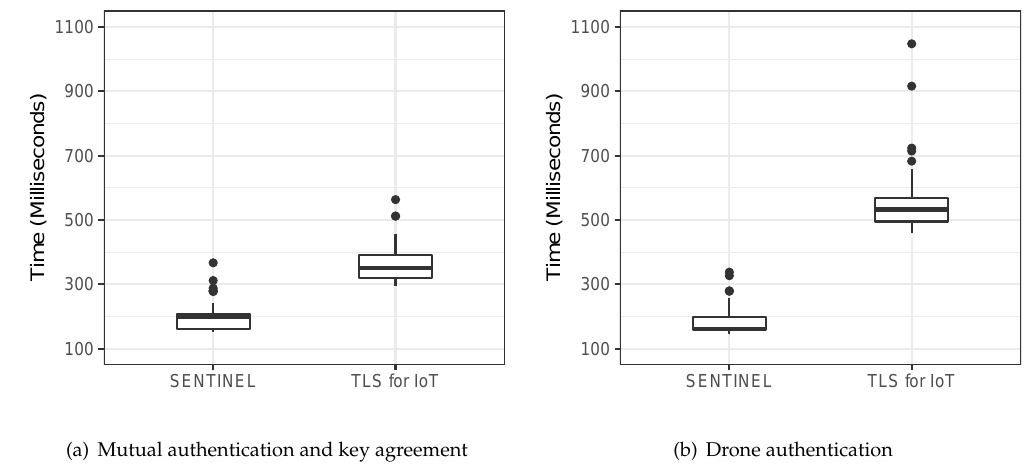
Figure 8. Execution time comparison between SENTINEL and “TLS for IoT.”